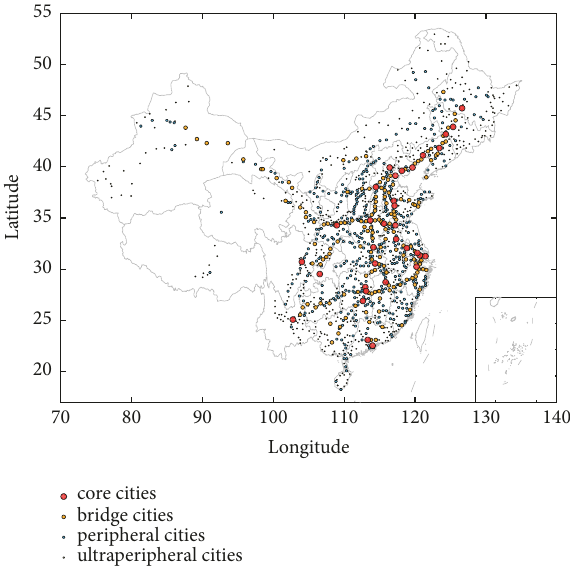
Figure 8: The spatial distribution of the cities in different categories according to the proposed integrated